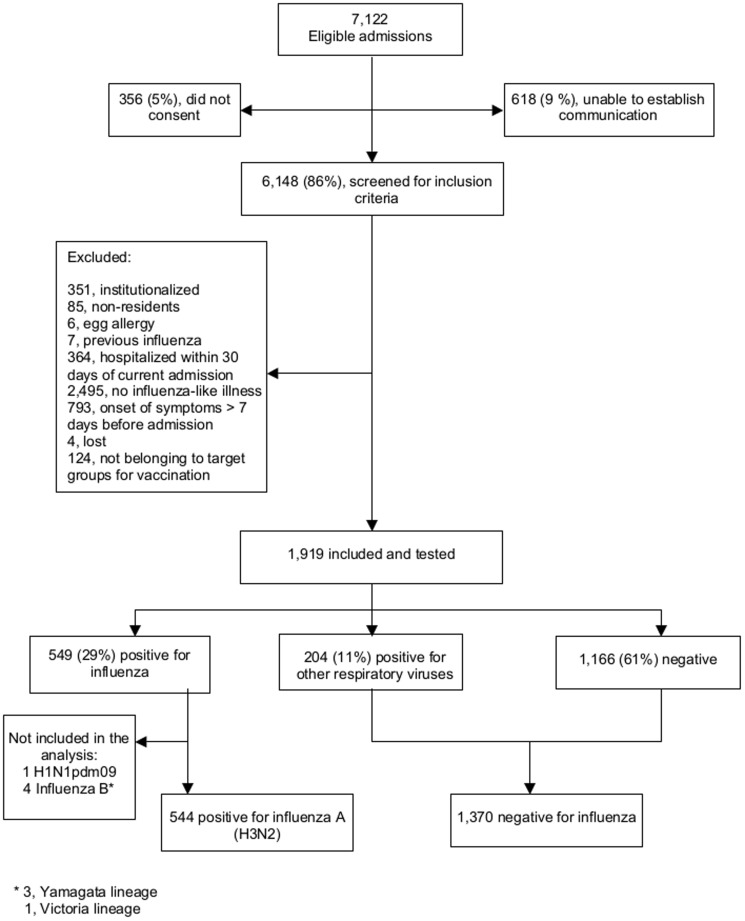
Flow diagram of study subjects.